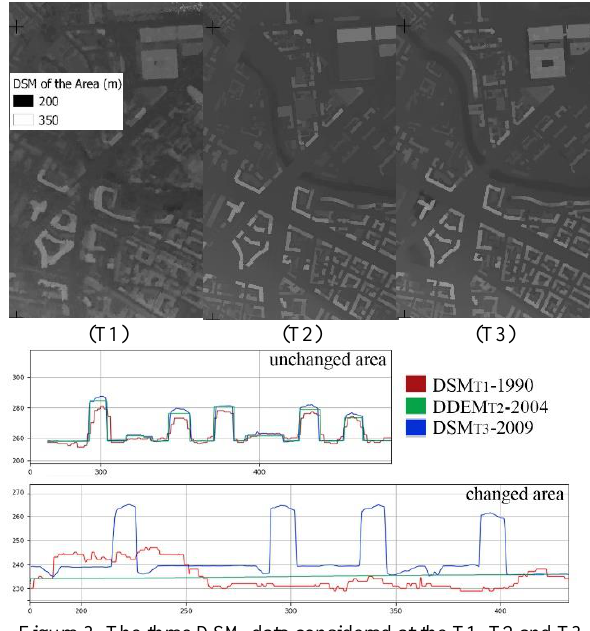
Figure 3. The three DSM data considered at the T1, T2 and